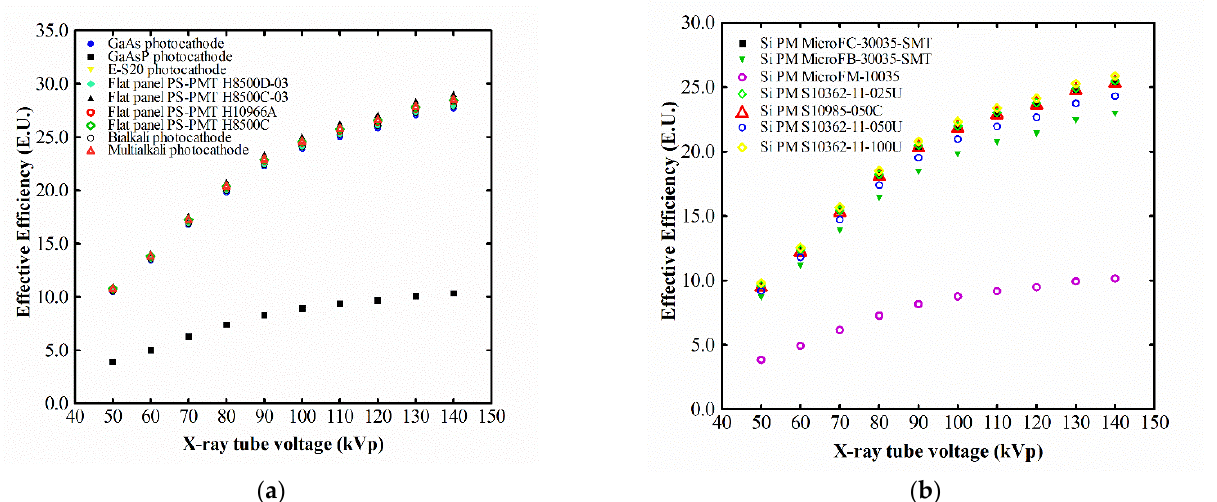
Figure 5. CeBr 3 effective efficiency with: ( a ) photocathodes; ( b ) silicon photomultipliers.